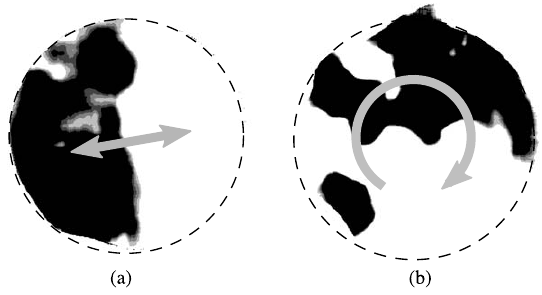
Fig. 1. Oscillation patterns of the Physarum plasmodium in a single well:(a)bilateralshuttleoscillationand(b)clockwiserotationwave. Black and white regions indicate areas where thickness is increasing and decreasing,